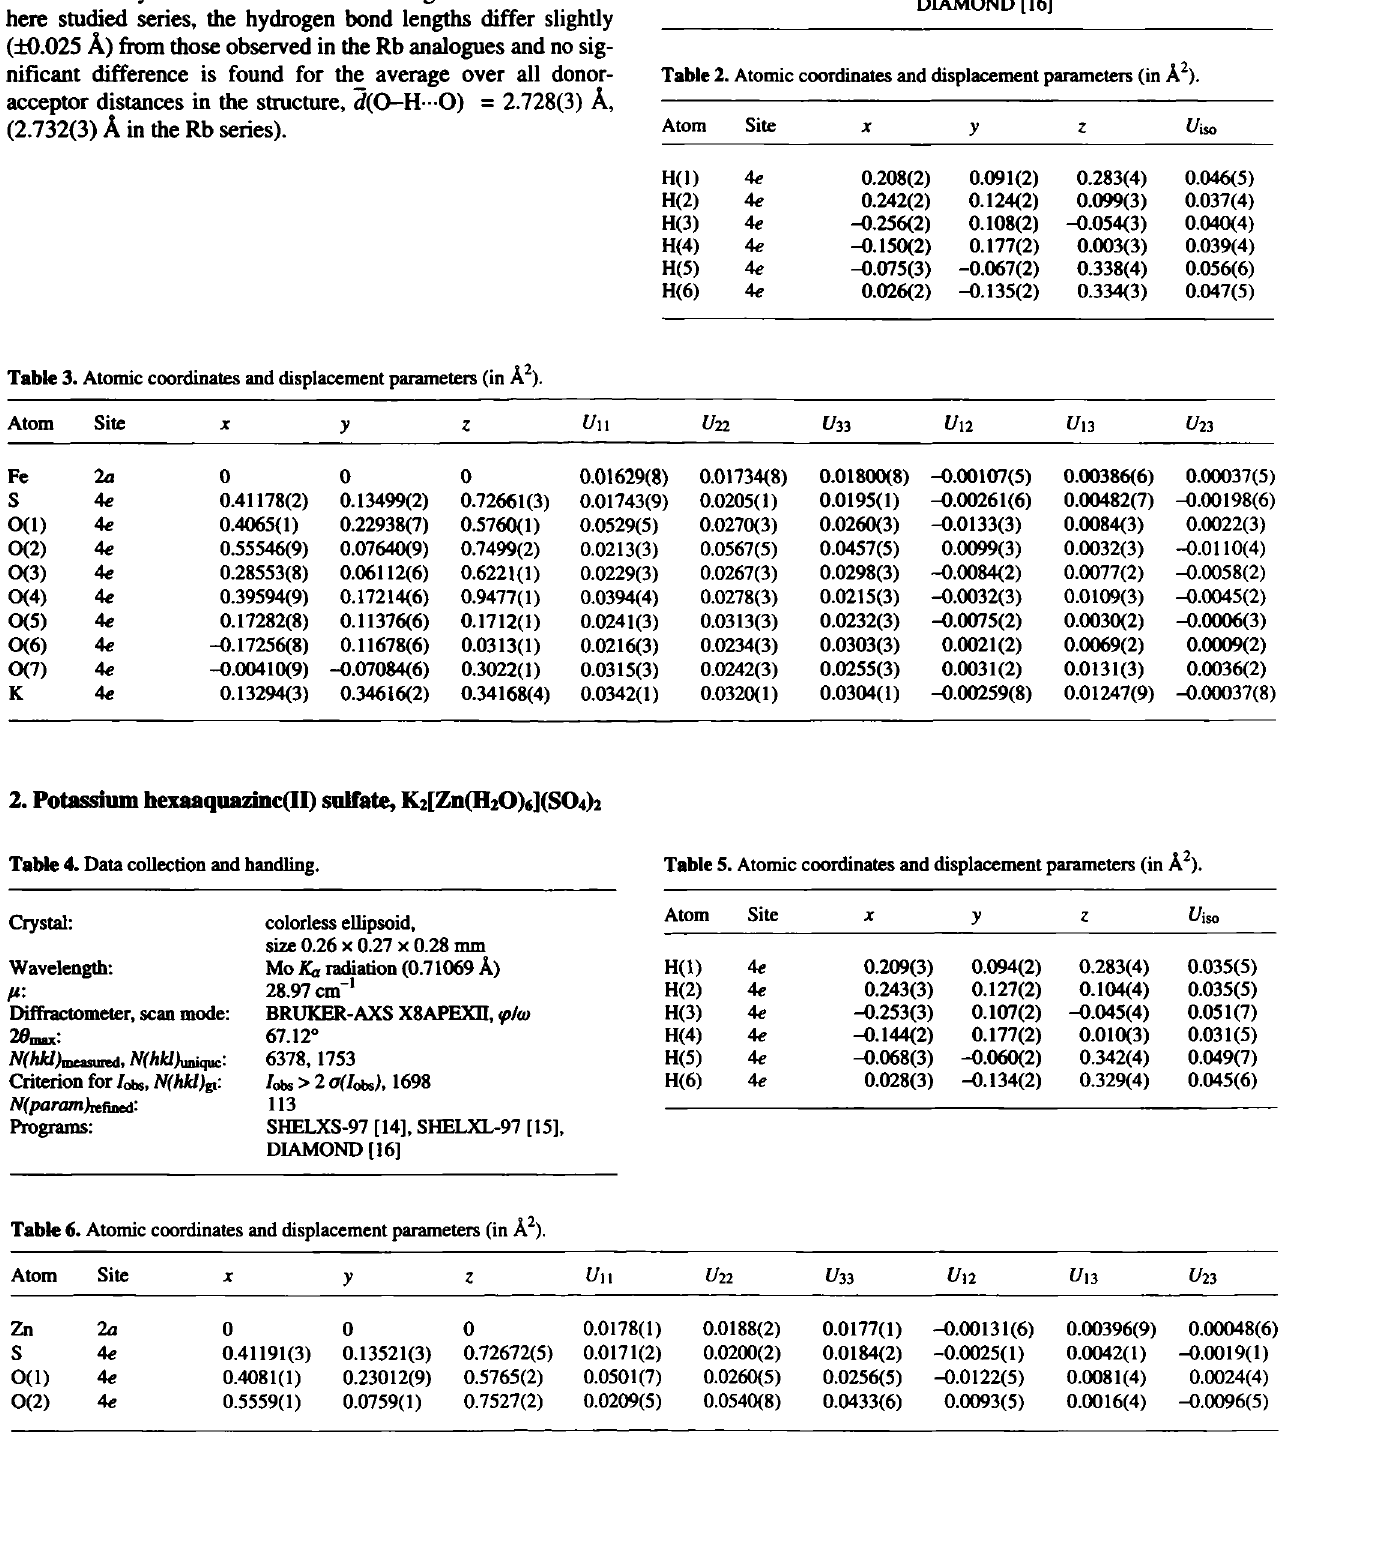
Table 2. Atomic coordinates and displacement parameters (in À 2 ).